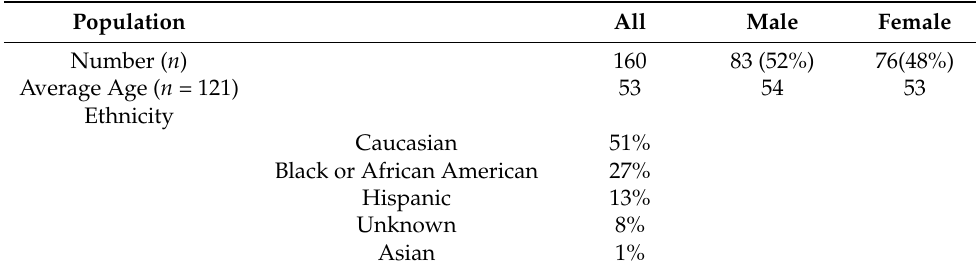
Table 5. Combined subject demographics, gender, age and